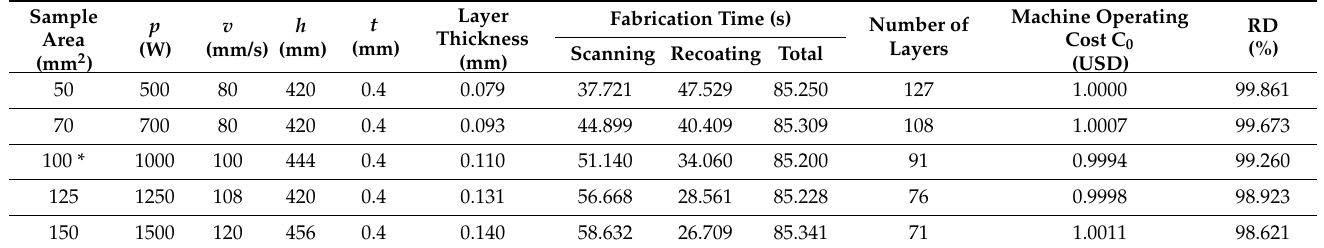
Table 7. Results of the variation in the sample area with Model 1.